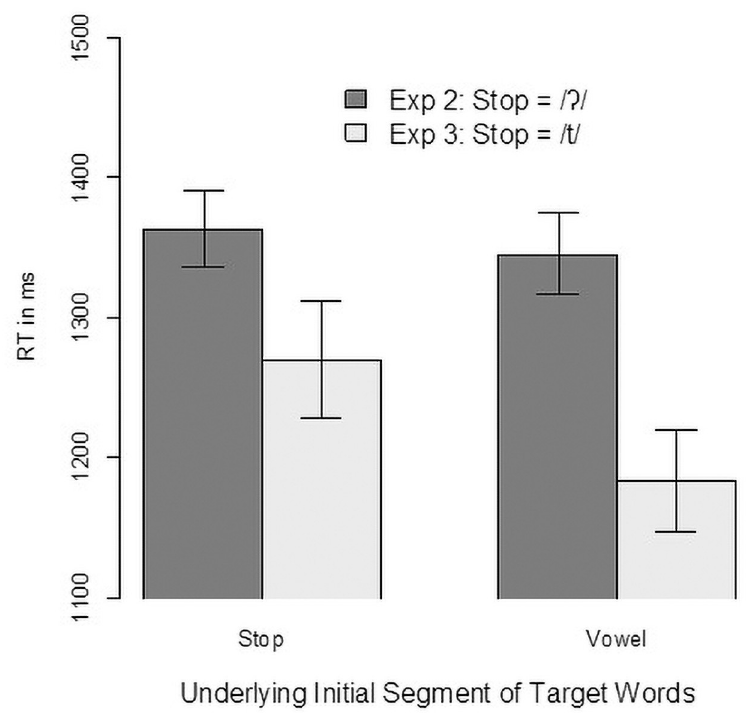
Fig 8. Reaction times from Experiment 3 (/t/-initial words) compared with Experiment 2 (/ ʔ /-initial words).